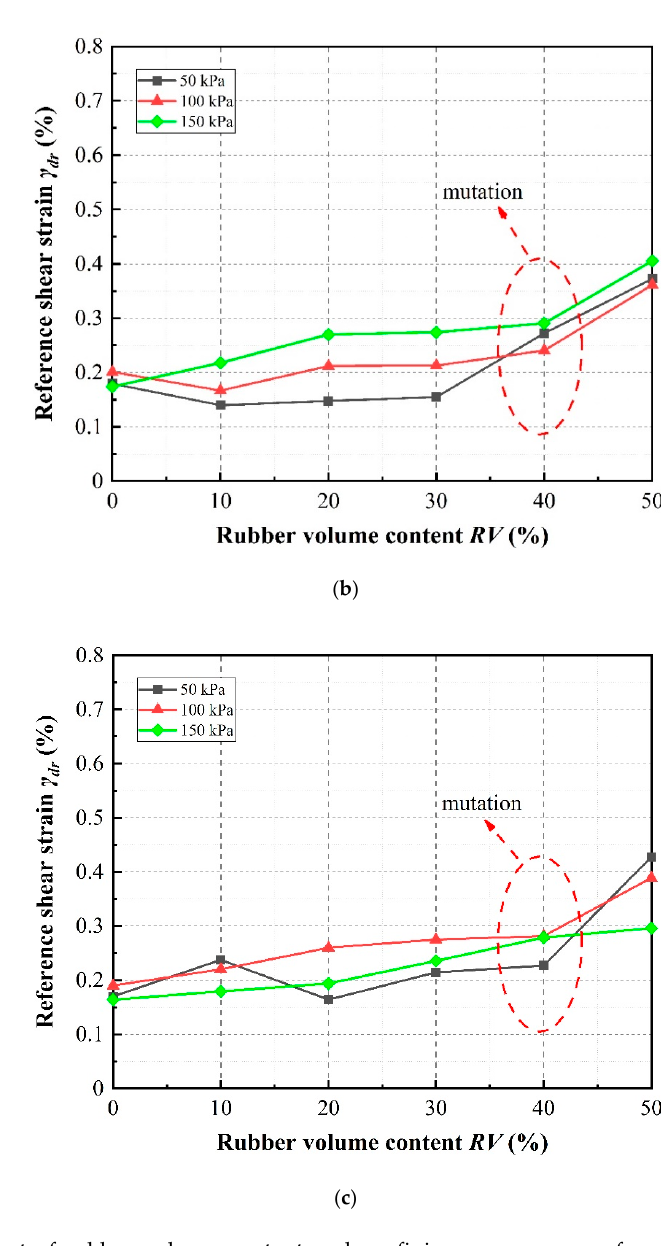
Figure 20. Effect of rubber volume content and confining pressure on reference shear strain of sand– rubber mixtures with different rubber particle sizes: ( a ) SRP1; ( b ) SRP2; ( c ) SRP3.